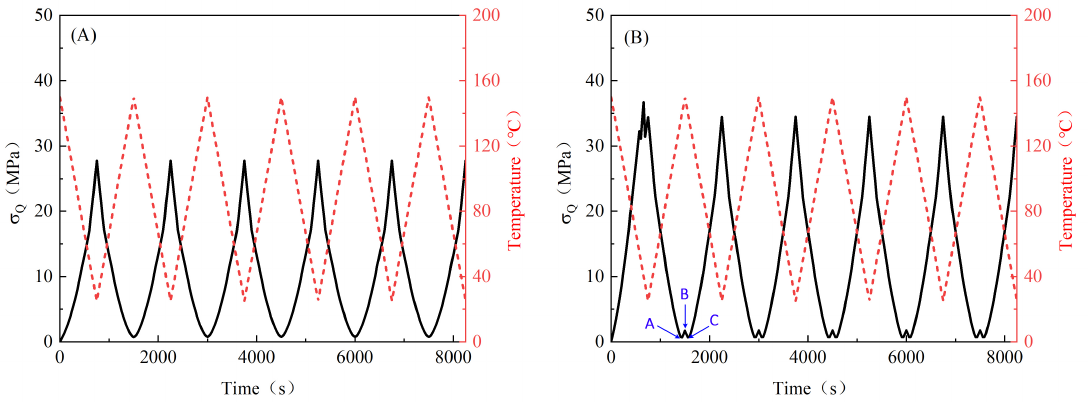
Figure 7. Stress evolution at Q-point of model III under the ( A ) fixed constraint and ( B ) non- fixed